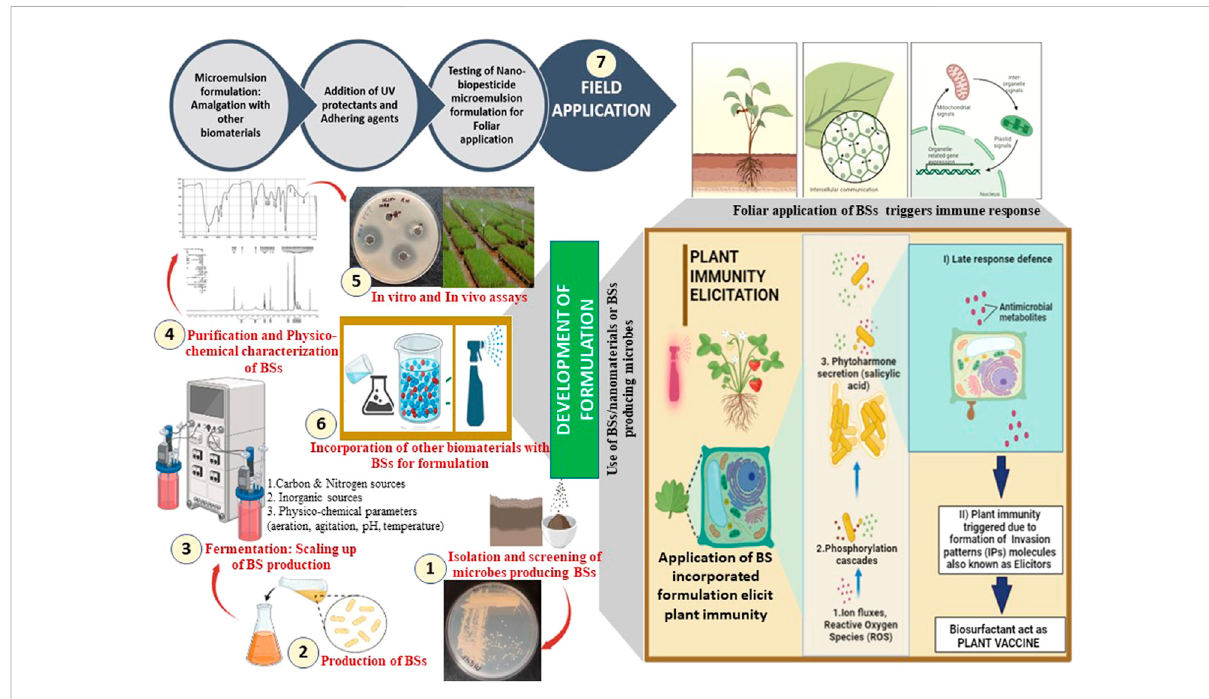
FIGURE 2 Application of a formulation incorporating biosurfactants (BSs) in the elicitation of plant immune